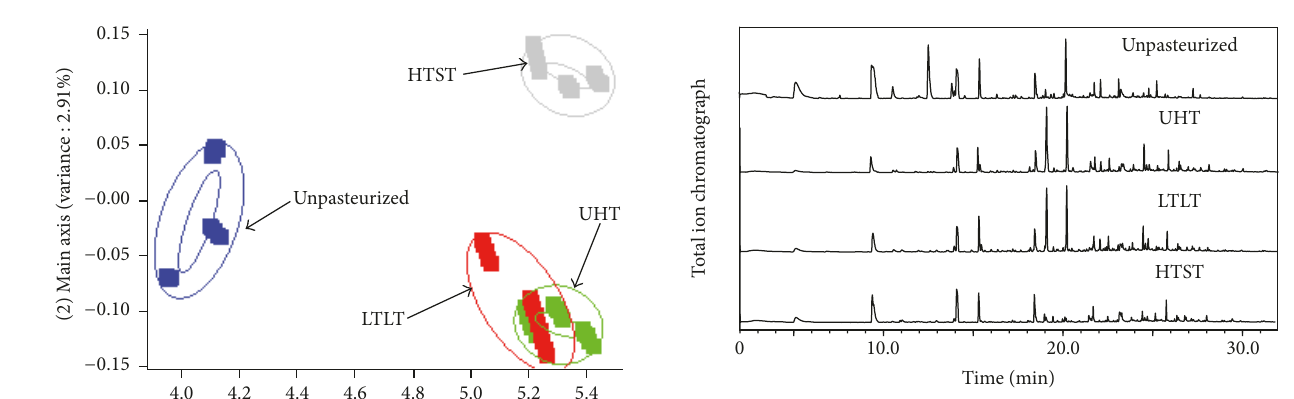
Figure 4: Total ion chromatographs of the watermelon juice. UHT: ultrahigh temperature; LTLT: low temperature long time; HTST: high temperature short